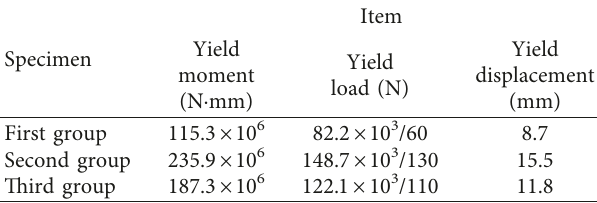
Table 2: Yield loads and yield displacements.